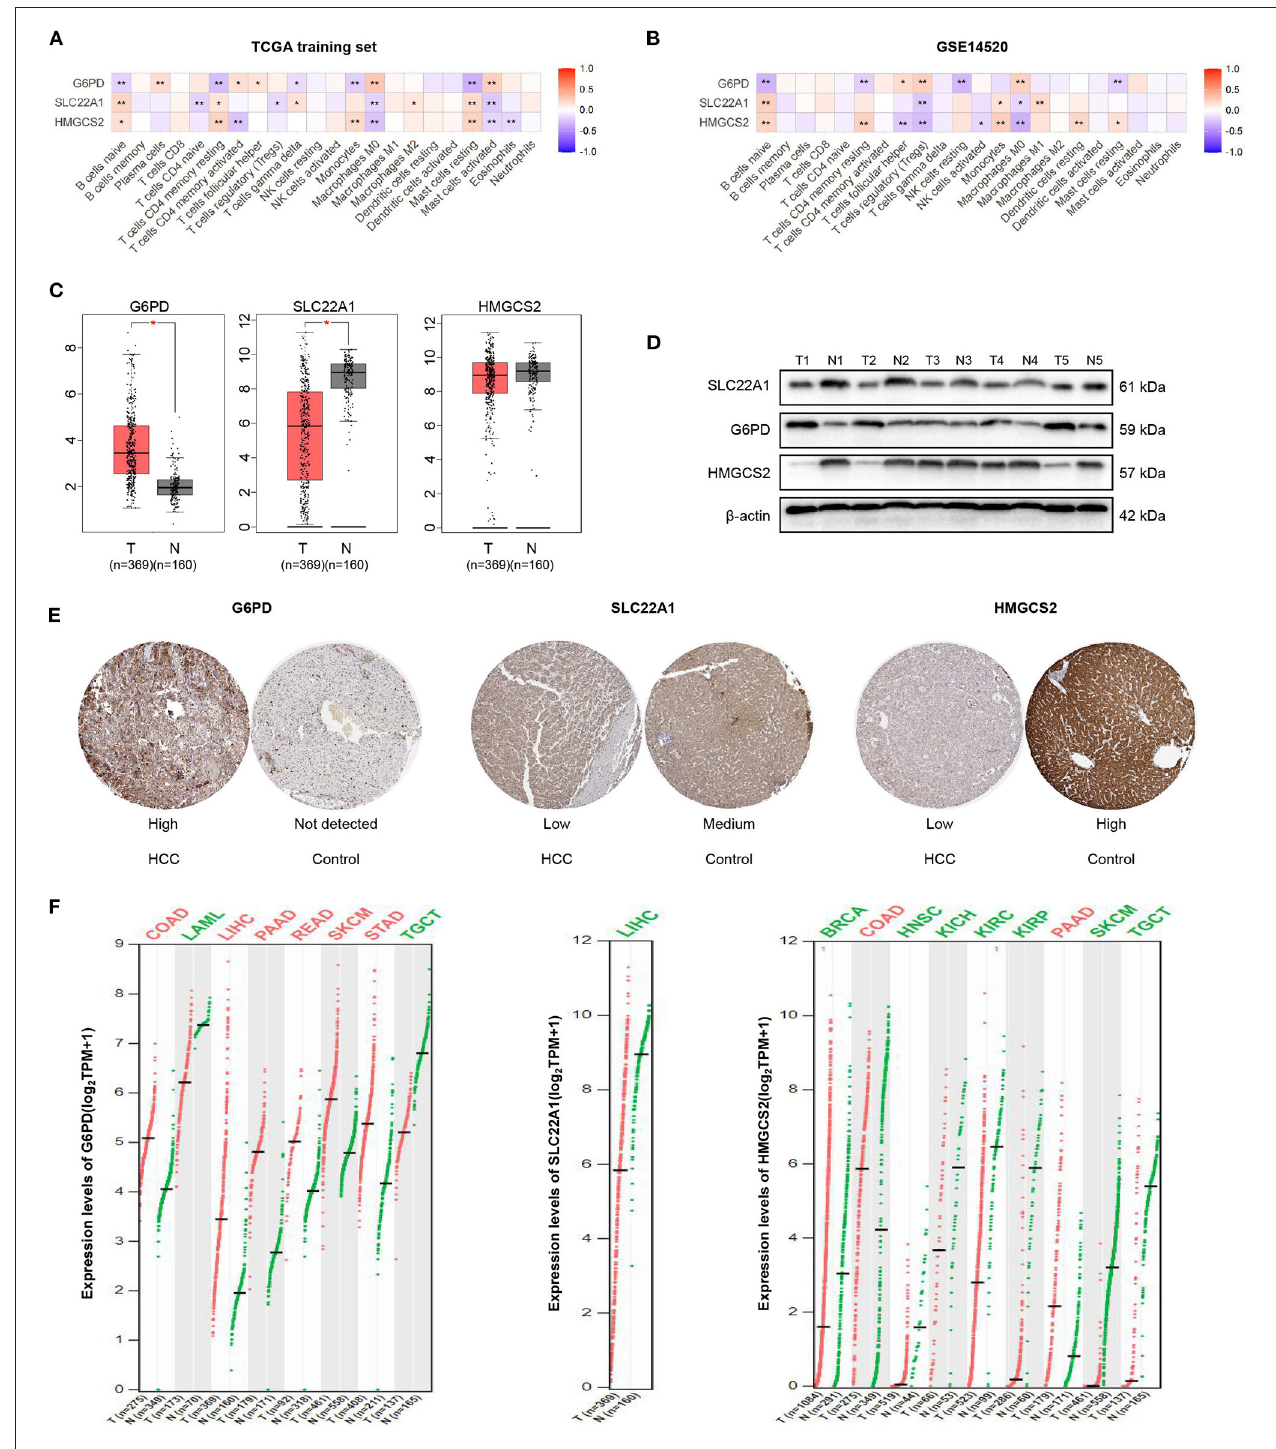
FIGURE 7 | Correlation analysis and expression analysis of the 3 genes. (A,B) Correlation of the 3 genes and 22 immune cells. (C) mRNA expression levels of the 3 genes in HCC according to GEPIA. (D) Protein expression levels of the 3 genes in HCC and tumor-adjacent tissues according to western blotting. (E) Immunohistochemical staining of the 3 genes in HPA. (F) Comparison of the expression of the 3 genes in different tumors according to GEPIA. The colors represent statistical significance. The red color represents high expression in cancer, and the green color represents low expression in cancer. * p < 0.05; ** p < 0.01.